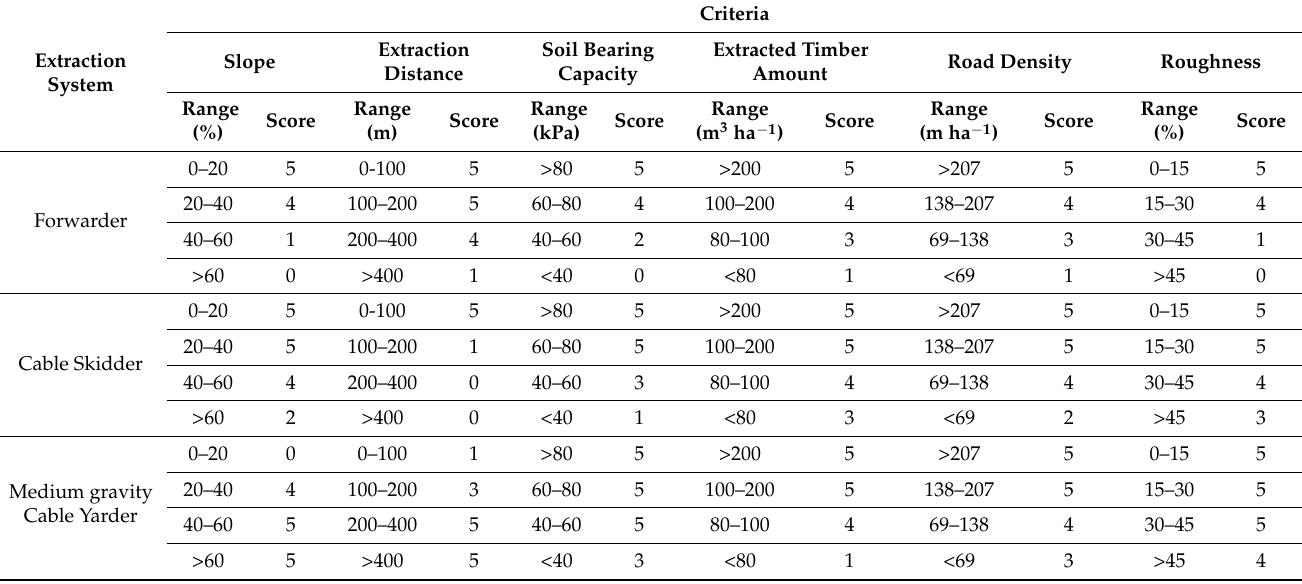
Table 2. Suitability criteria classes for the different investigated extraction